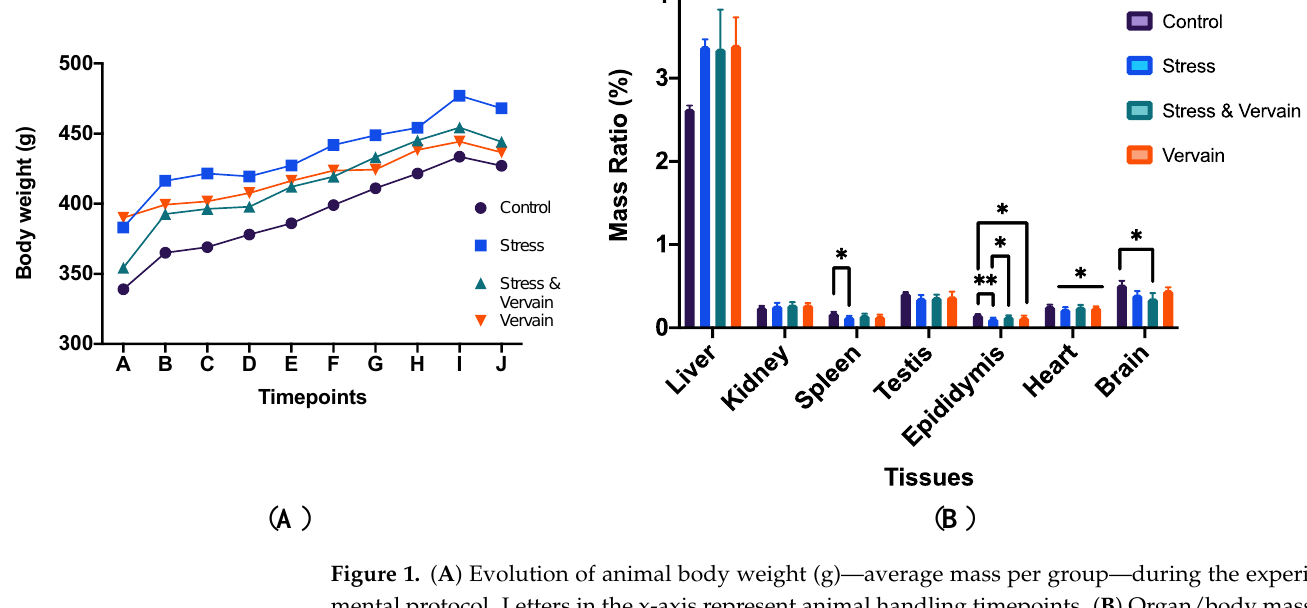
Figure 1. ( A ) Evolution of animal body weight (g) — average mass per group — during the experimental protocol. Letters in the x-axis represent animal handling timepoints. ( B ) Organ/body mass ratio (%) in the several groups. * — Statistically different from control ( p ≤ 0.05); **— Statistically different from stress group ( p ≤ 0.01).